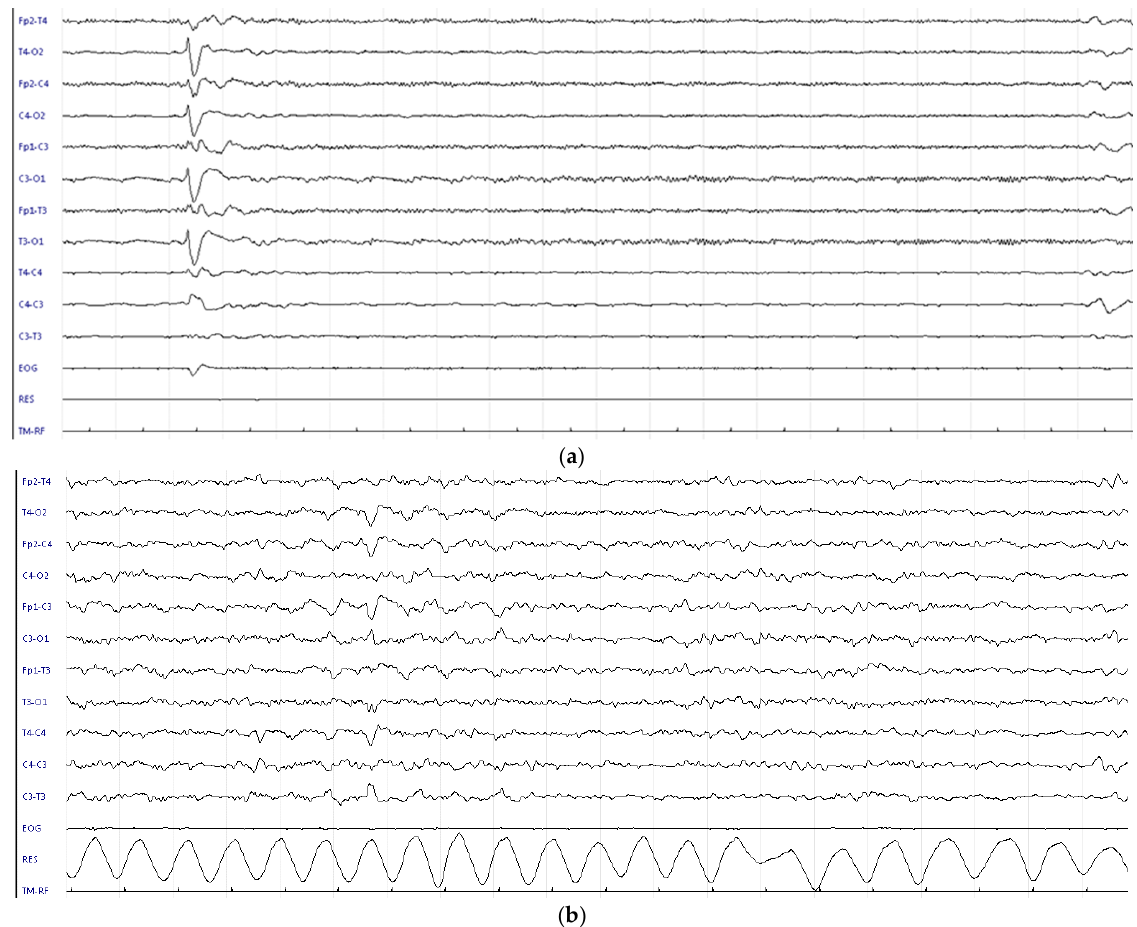
Figure 2. p-EEG in case 2 ( a ) at recruitment: severe p-EEG depression with superimposed muscular activity; ( b ) at 24 h during TH: mild to normal pEEG. Children 2022 , 9 , x FOR PEER REVIEW